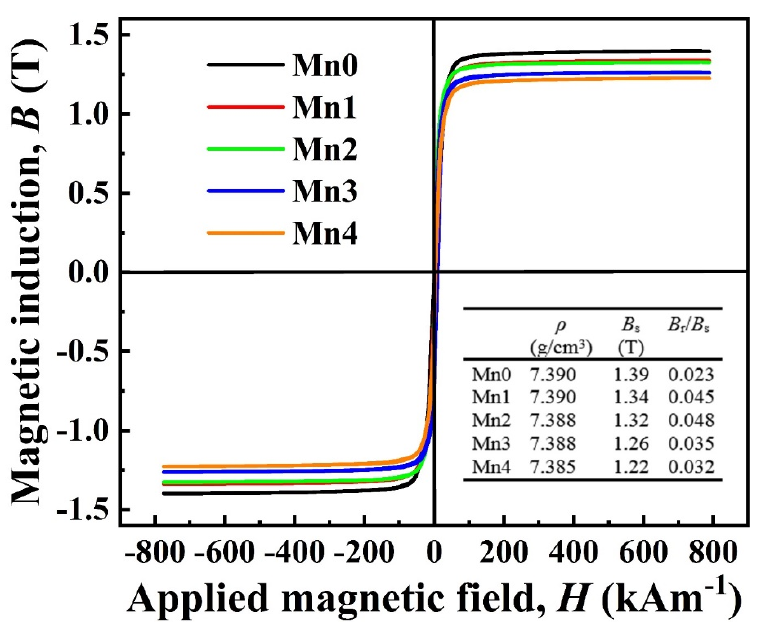
Figure 3. Hysteresis loops of Mn0, Mn1, Mn2, Mn3, and Mn4 annealed at optimal T a . Inset shows